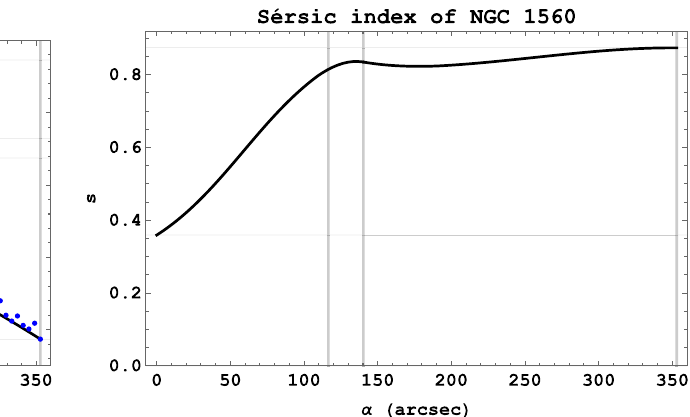
correspond to the effective half-angle α eff ∼= 116 . 5arcsec and to the transition point α 0 ∼= 140 . 3arcsec between the bulge and disk regions ( r eff ∼= 1 . 69 kpc and r 0 ∼= 2 . 04 kpc). The profiles extend to the last